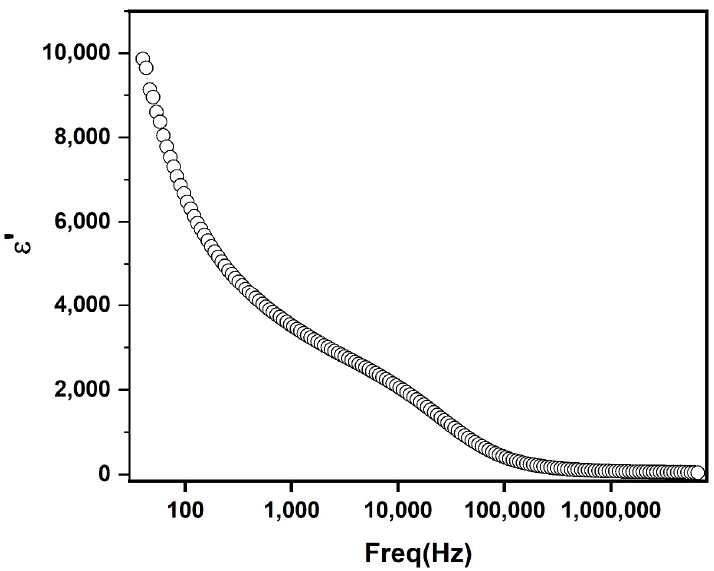
Figure 8. Variation of real part of dielectric constant with frequency for PbS.